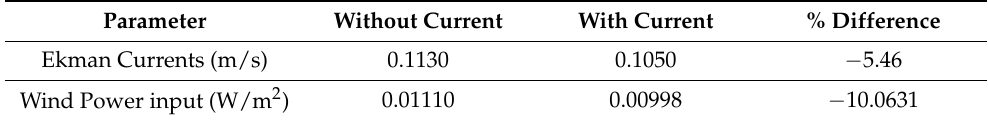
Table 3. Basin wide area averages of Ekman currents and wind power input. Parameter